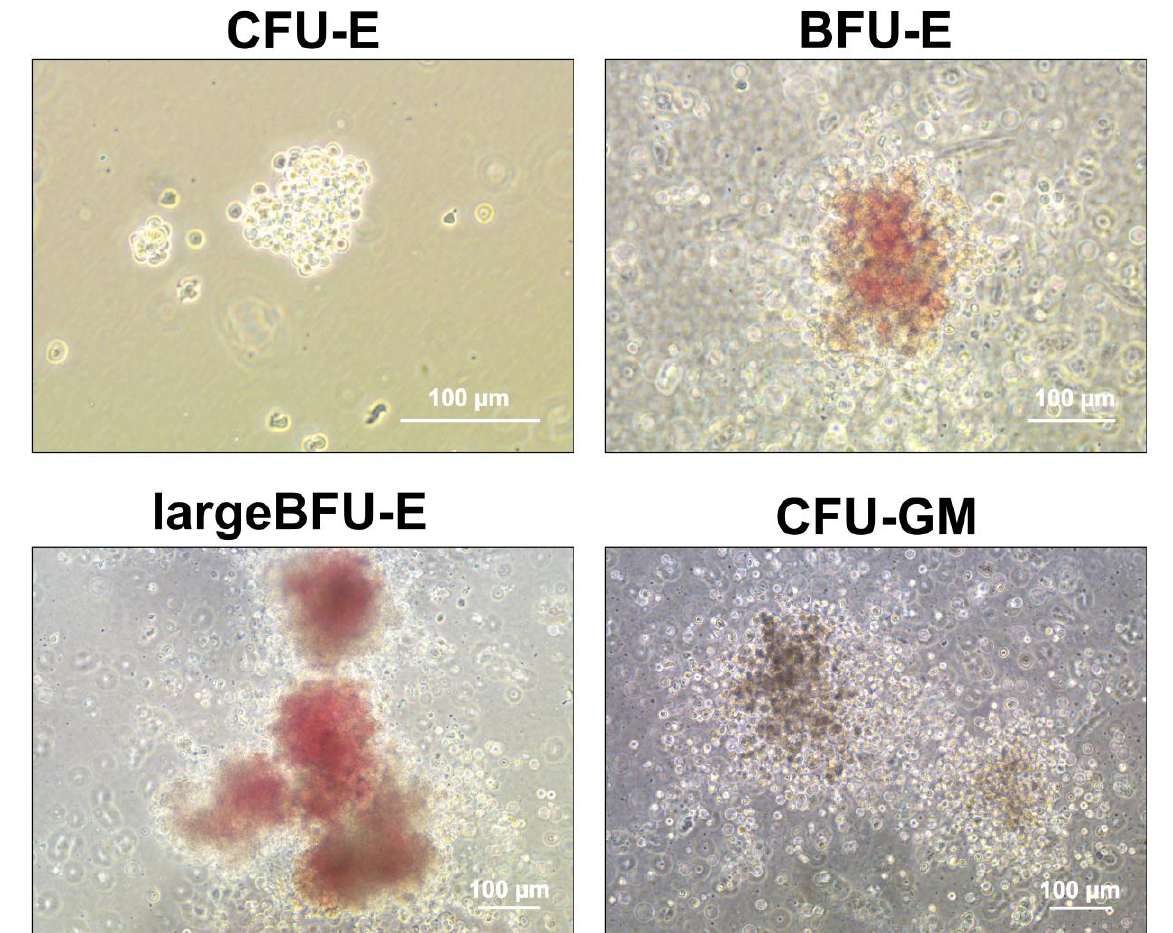
Figure 4. Representative images of Colony Forming Unit (CFU) assay from iPSC-derived HSCs.